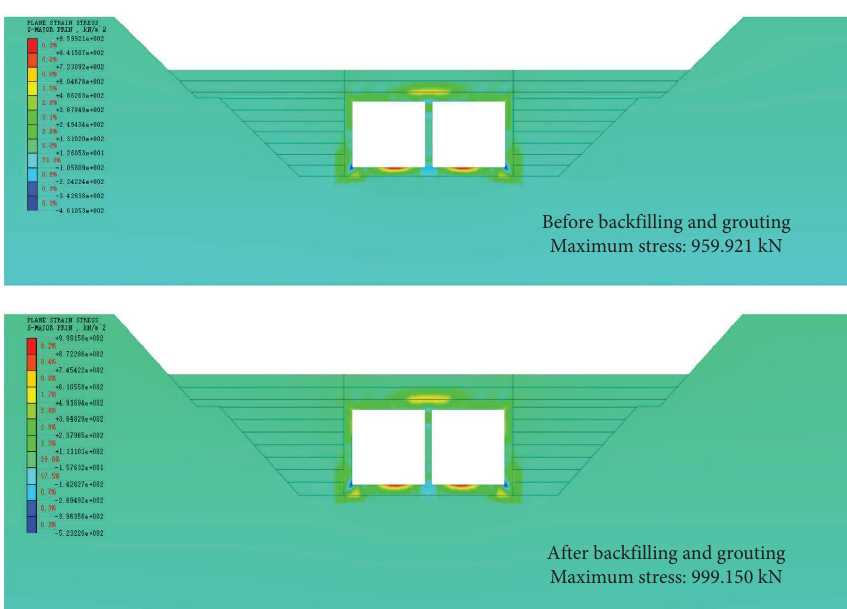
Figure 23: Overall stress changes of the model before and after